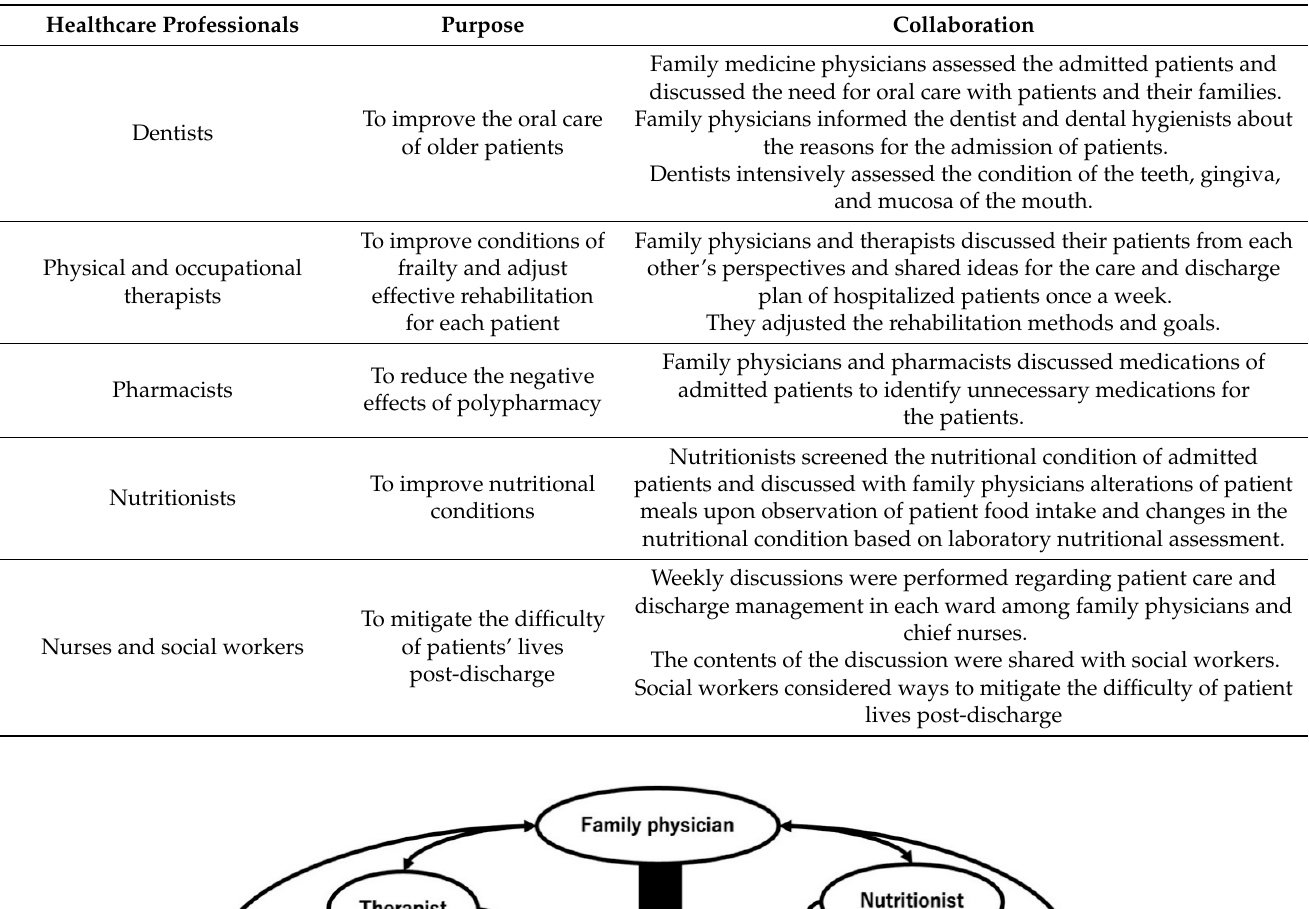
Table 1. Concrete interprofessional collaboration of family physicians with other healthcare professionals.